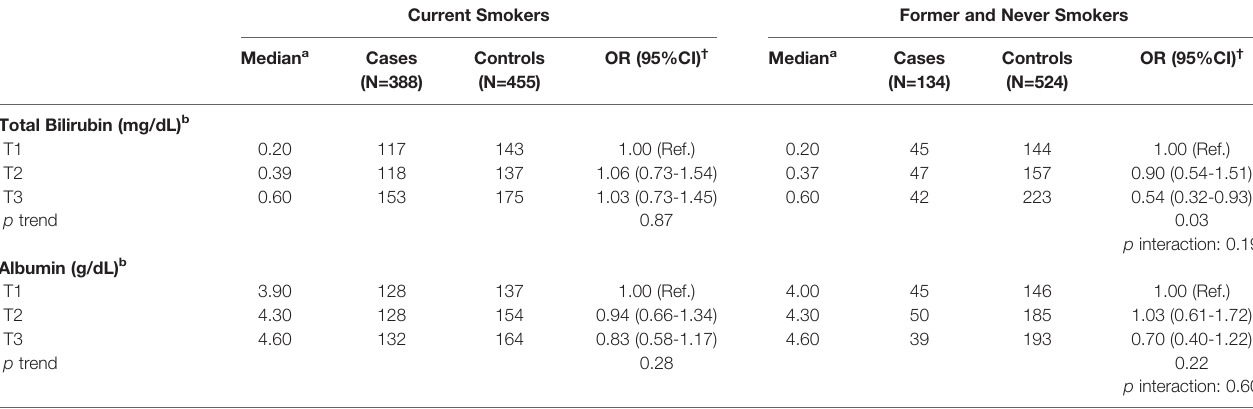
TABLE 4 | Association of serum levels of total bilirubin and albumin with lung cancer risk by smoking